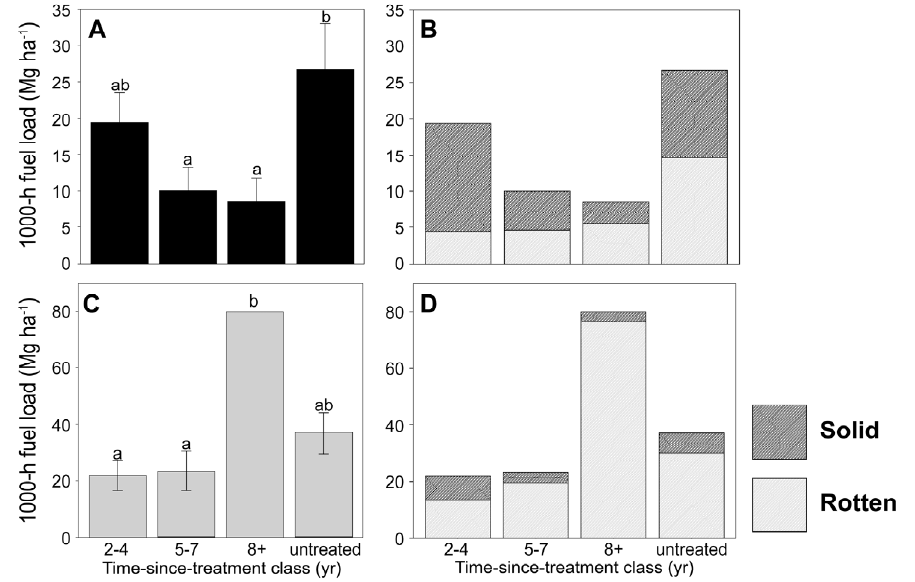
Figure 7. Thousand-hour timelag class (diameter >7.62 cm) fuel load in eastside pine ( A , B ) and mixed conifer ( C , D ) sites treated with mechanical thinning alone or untreated. A , C : Different letters above each bar indicate significant difference in means between groups (Tukey’s HSD multiple comparison test, p < 0.05); B , D : Total thousand-hour fuels by decomposition